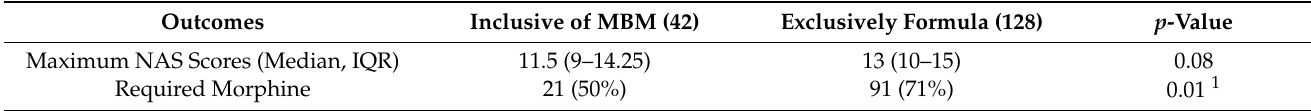
Table 3. Effect of Feeds on NAS Scores and Need for